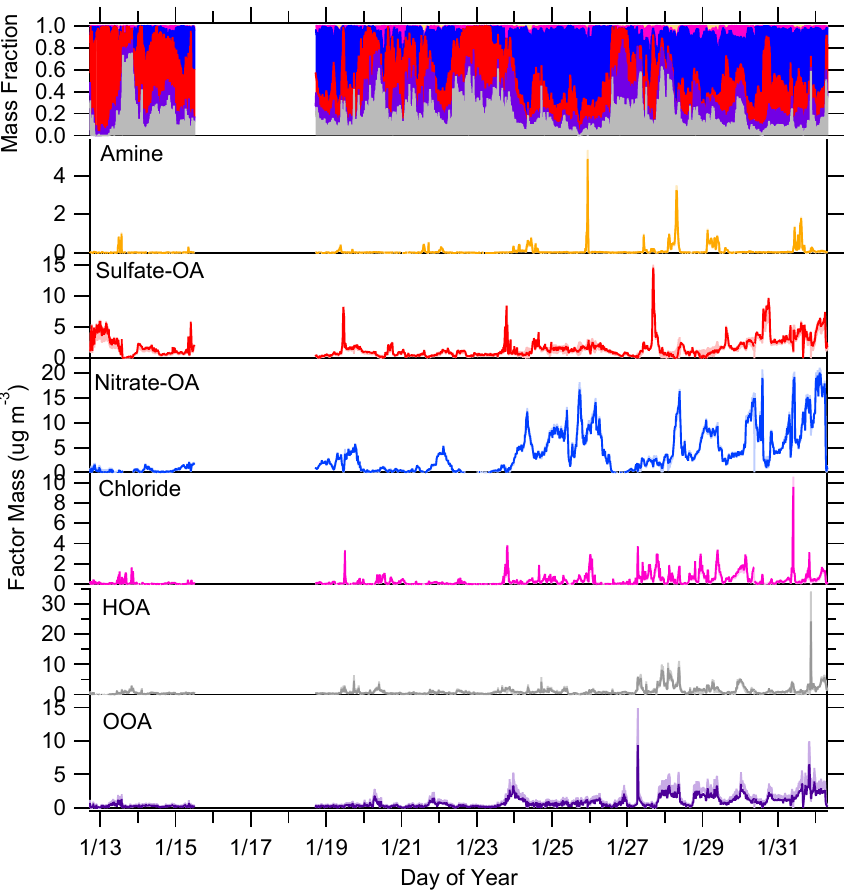
Figure 4. Time series of the factors from the six-factor solution from PMF Full MS analysis. The solid line represents FPeak = 0, and the range of uncertainties through FPeak analysis ( − 10 and + 10) is shown in the shaded